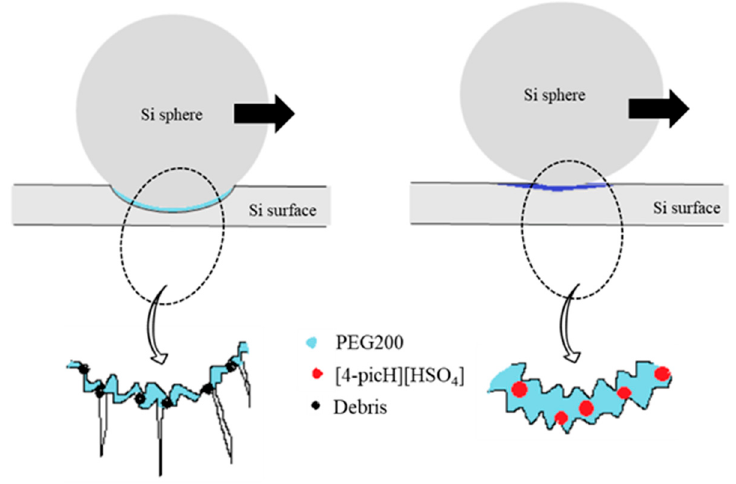
Figure 9. Schematic representation of the lubrication process during the tribological tests under high load.